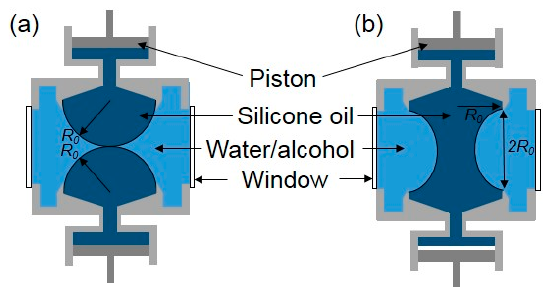
Figure 6. The Plateau tank for the droplet coalescence experiment in silicone oil. ( a ) The configuration of the droplets touching each other; ( b ) the equilibrium shape of the droplets after coalescence.